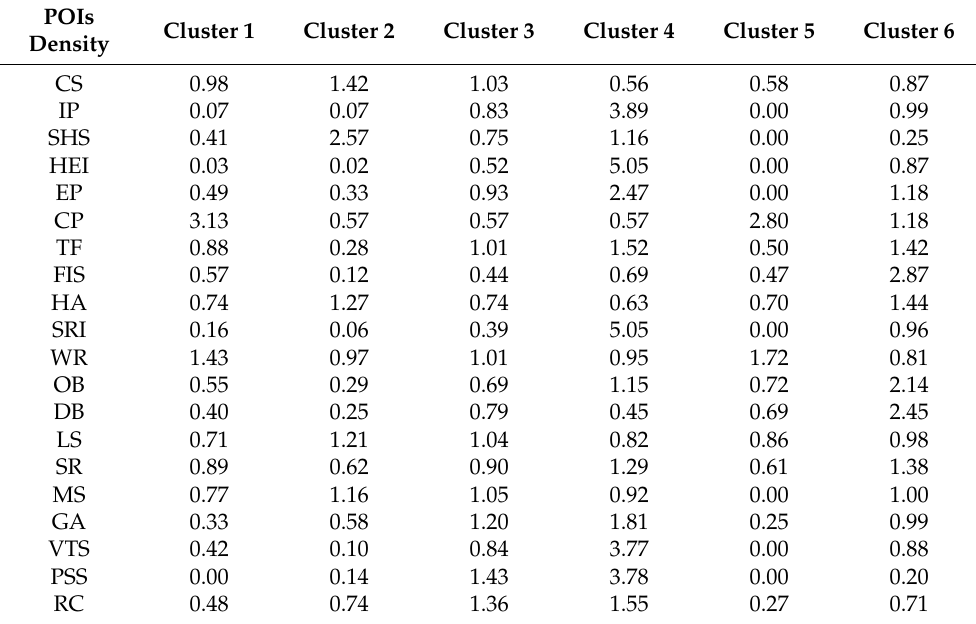
Table 2. Density index values of POIs in different categories grouped by clusters.